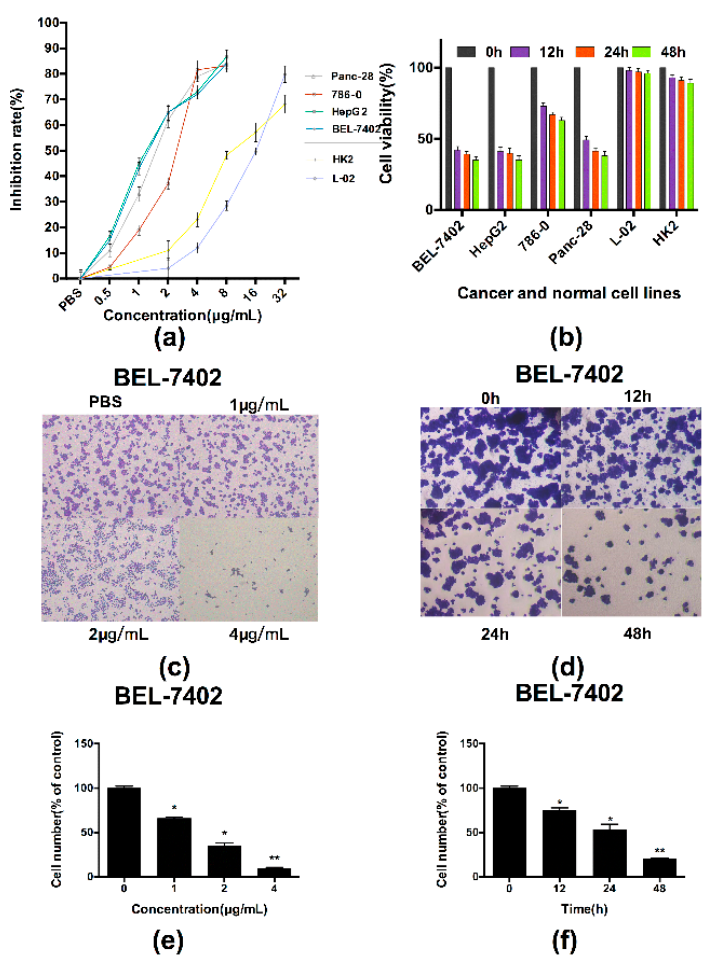
Figure 3. PBN11 ‐ 8 displays potent cytotoxicity to cancer cells. ( a ) Cells were treated with certain concentrations of PBN11 ‐ 8. The cell inhibitory rate was determined by MTT assay as described in the experimental section. The IC 50 values were 1.56, 1.80, 1.57 and 1.73 μ g/mL for BEL ‐ 7402, 786 ‐ 0, HepG2 and Panc ‐ 28 cells, respectively. The IC 50 values were 11.79 and 14.72 μ g/mL for HK2 and L02 cells, respectively. ( b ) Cells were cultured in a 96 ‐ well plate and treated with 4 μ g/mL PBN11 ‐ 8 for each cell line for 0, 12, 24, and 48 h to study the time dependent analysis. Cell viability was analyzed by MTT assay. ( c ) The results of the crystal violet adhesion assay in BEL ‐ 7402 cells induced by 1, 2, 4 μ g/mL of PBN11 ‐ 8 for 12 h. ( d ) The results of the crystal violet adhesion assay in BEL ‐ 7402 cells induced by 2 μ g/mL of PBN11 ‐ 8 for 12, 24 and 48 h. ( e , f ) The quantitative evaluations of the crystal violet adhesion assay. The data represent the mean ± SD of three independent experiments. * p < 0.05 vs. control; and ** p < 0.01 vs. control.